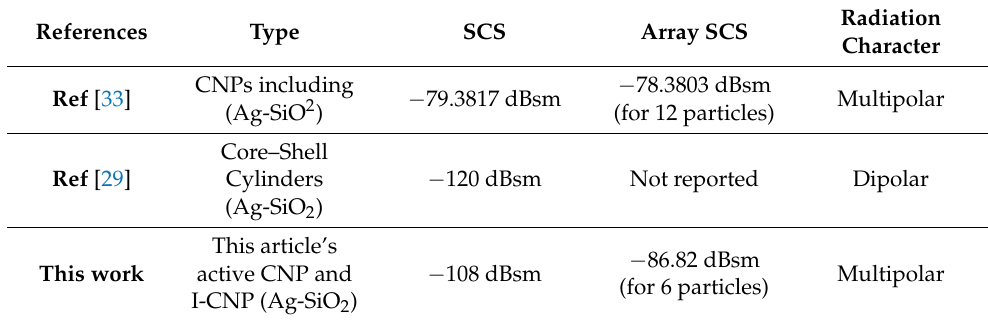
Table 3. The comparison with previously reported arrays.